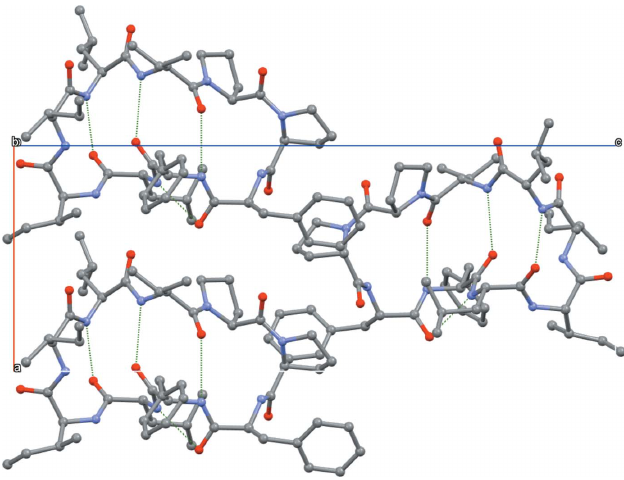
Figure 2 View along the b axis showing crystal packing of the title compound. The hydrogen bonds are shown as dashed lines and H atoms have been omitted for